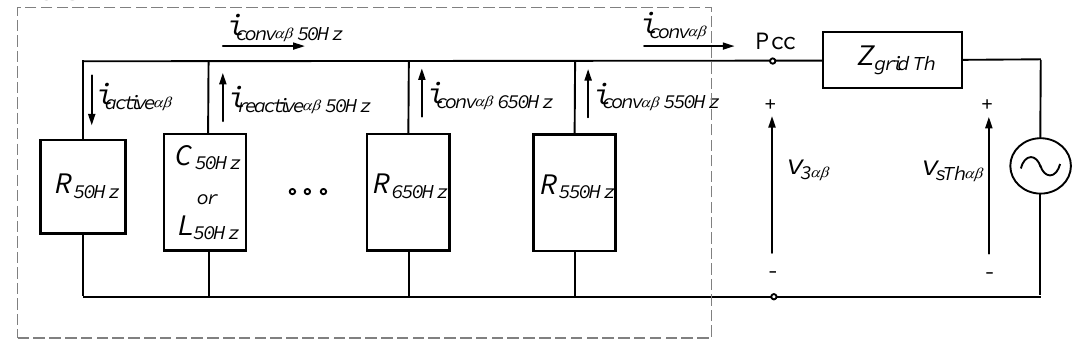
Figure 6. Schematic representation of the converter, behaving as an active impedance at selective frequencies.